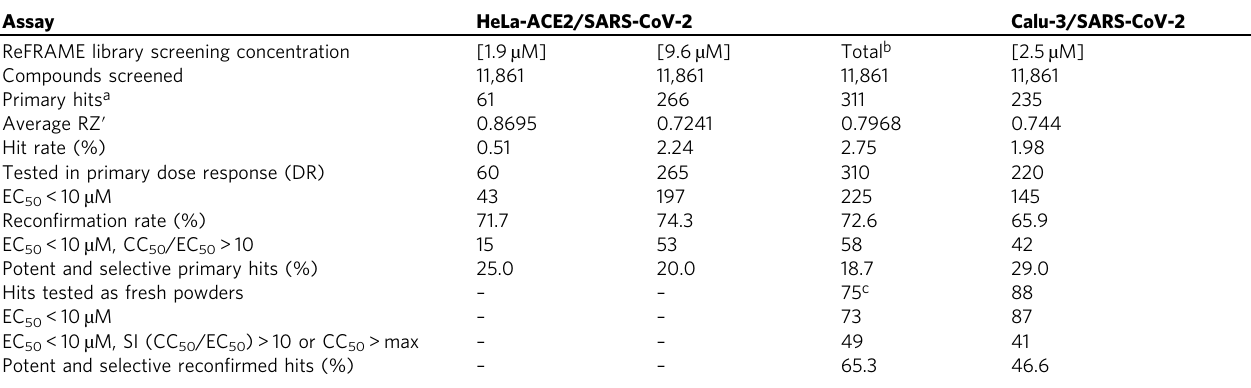
Table 1 ReFRAME primary and validation screen statistics for HeLa-ACE2 and Calu-3 SARS-CoV-2 infection assays. Assay HeLa-ACE2/SARS-CoV-2 Calu-3/SARS-CoV-2 ReFRAME library screening